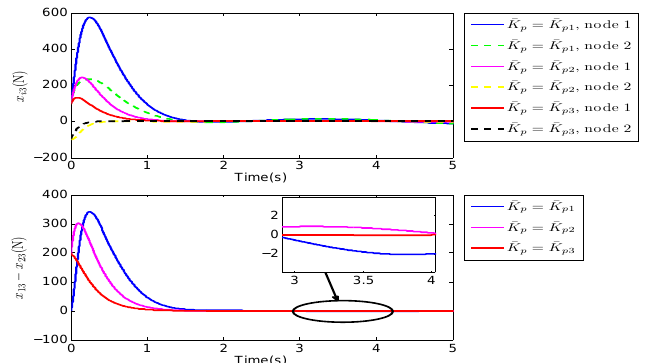
Figure 8. The comparative pressure response results of the three state-feedback matrices using pole placement in the